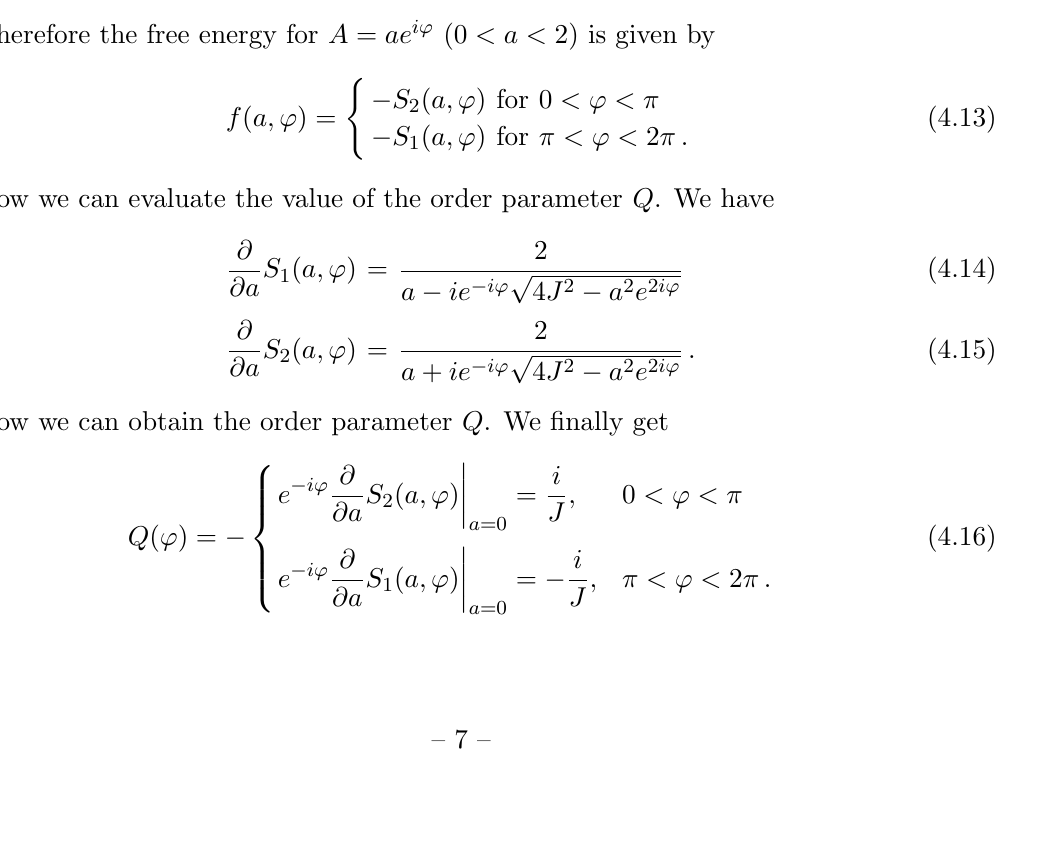
Figure 2 . Plots for real parts of the actions at the stationary point, ReS 0 ;i ( a; ’ ) for J = 1, 0 < a < 4 and 0 < ’ < 2 (cid:25) . i = 1 ; 2 corresponds to the (cid:12)rst and second stationary points and are presented by red and green color